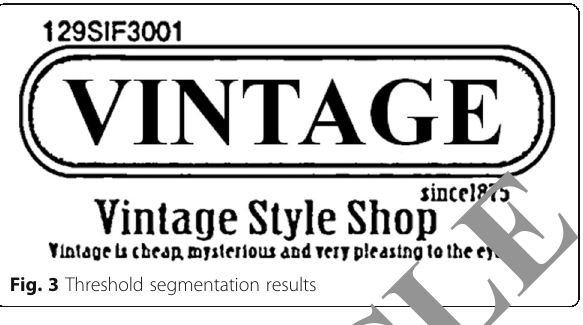
Fig. 3 Threshold segmentation